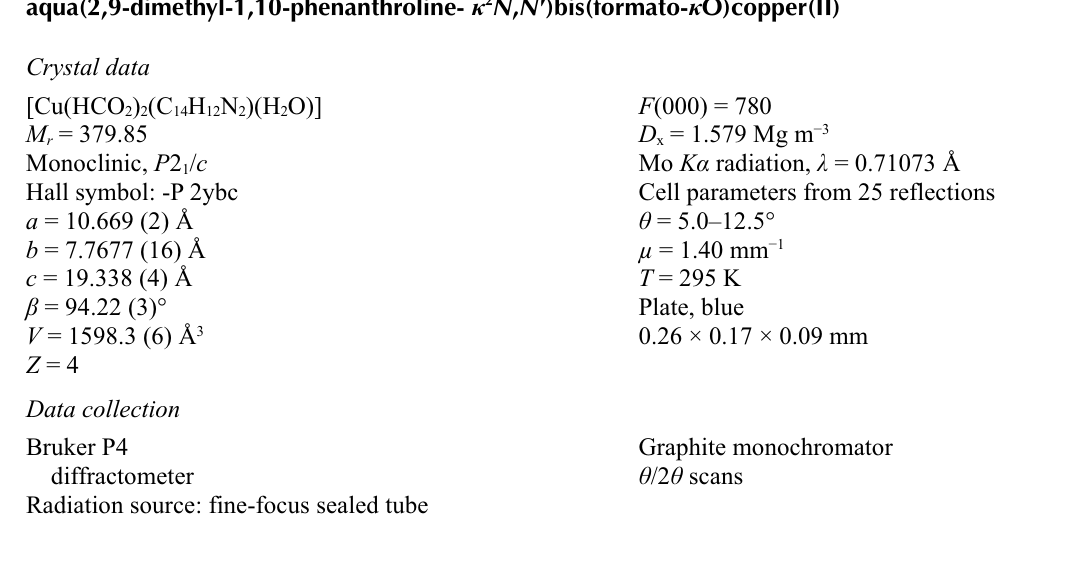
sup-3 Acta Cryst. (2008). E 64 , m1062